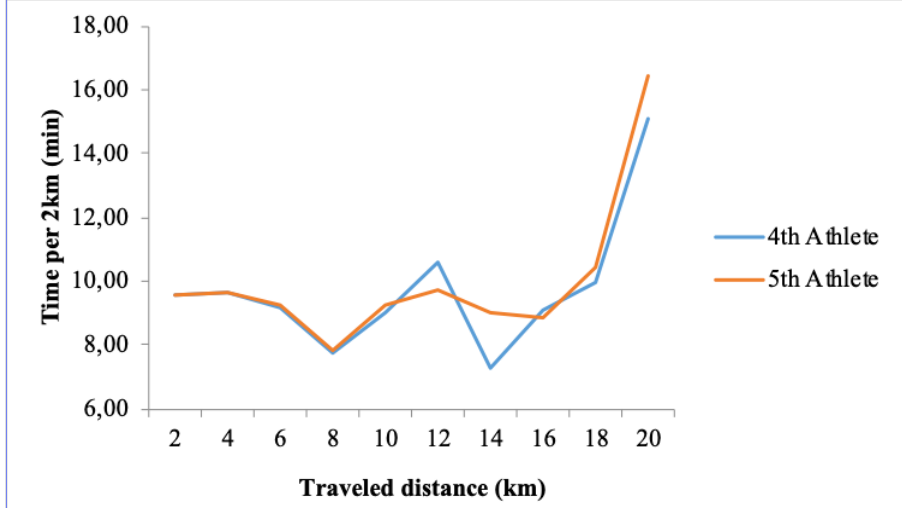
Figure 3 . The individual times per 2km of the group<15% of the athletes in the 20km of race walking